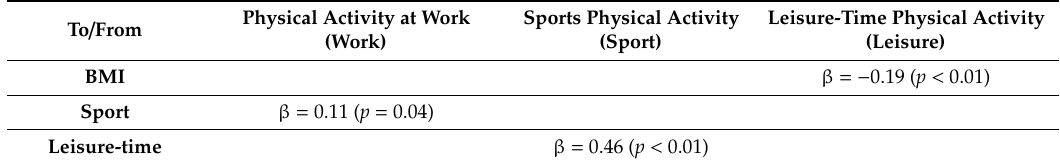
Figure 3. Model 2. Relationships between physical activity dimensions and BMI. Table 4. Model 2. Direct effects of the relationships between physical activity and BMI.